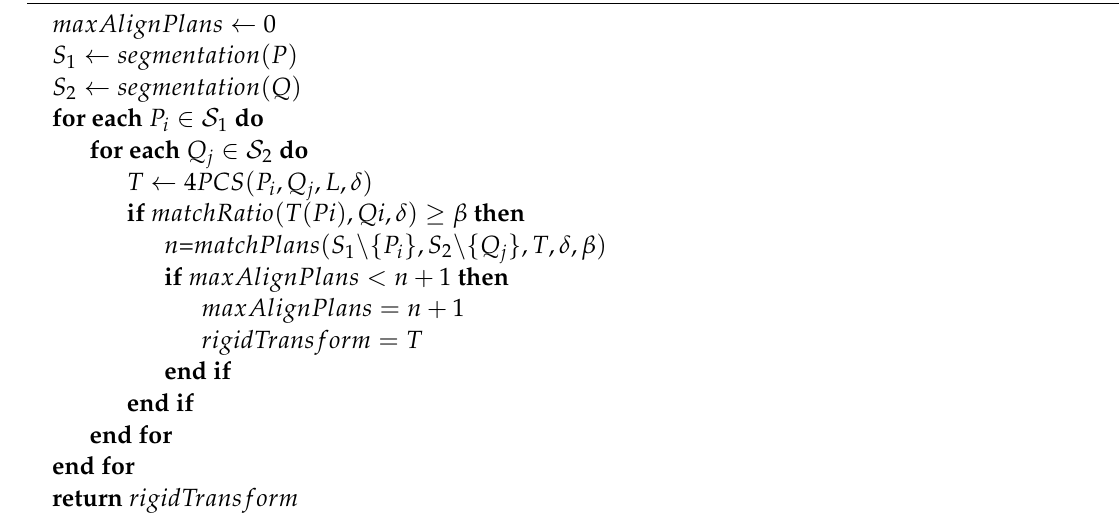
Algorithm 1 LCP-4PCS Given two point clouds P and Q in arbitrary initial positions, δ ∈ ] 0; 1 ] an approximation level, β ∈ ] 0; 1 ] an overlapping threshold and L > 0 a maximal